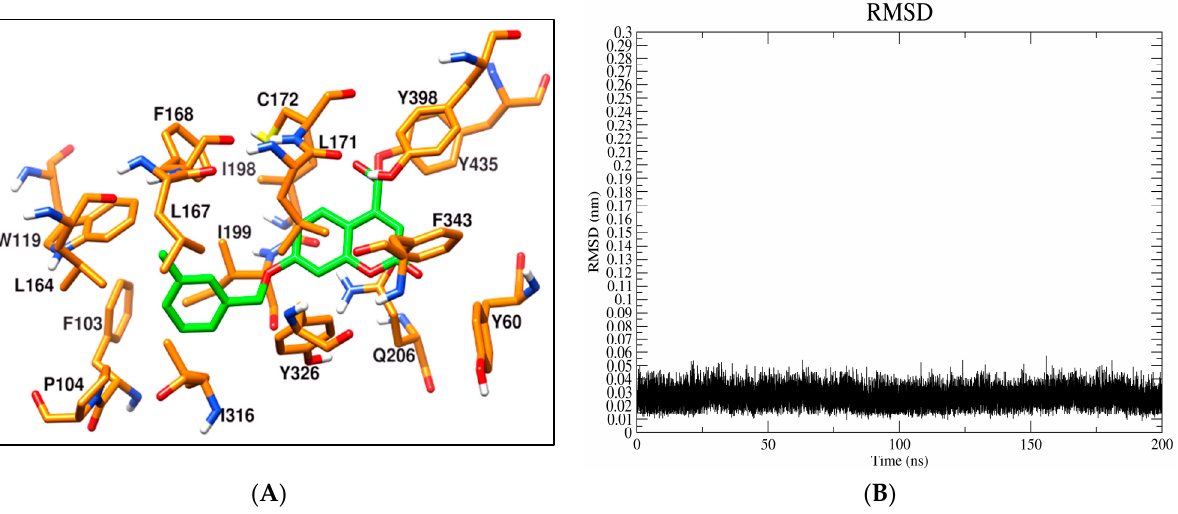
Figure 3. ( A ) Indicates the residues involved in the interaction with the ligand. ( B ) Indicates the RMSD plot of the ligand.